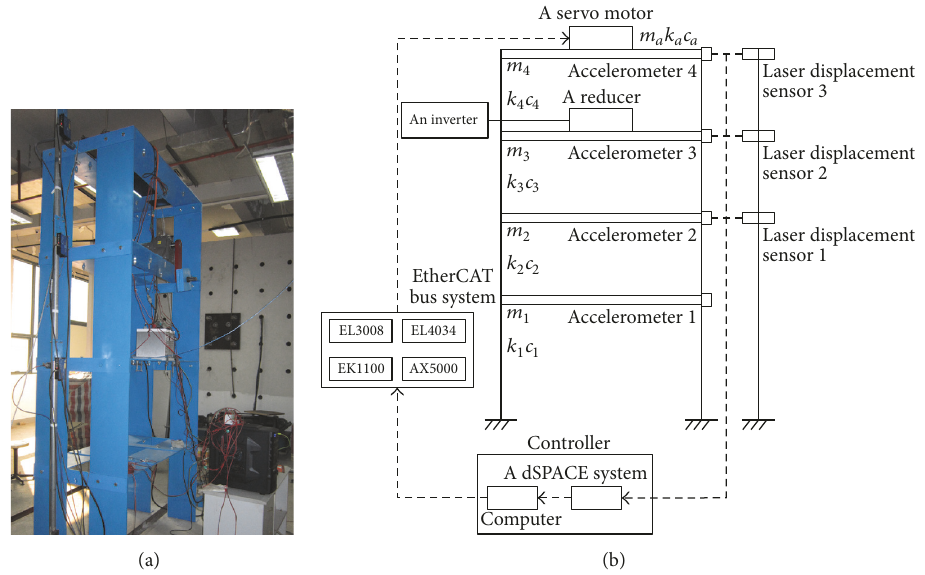
Figure 16: Pictures of the steel frame structure: (a) practicality; (b) exhibition.